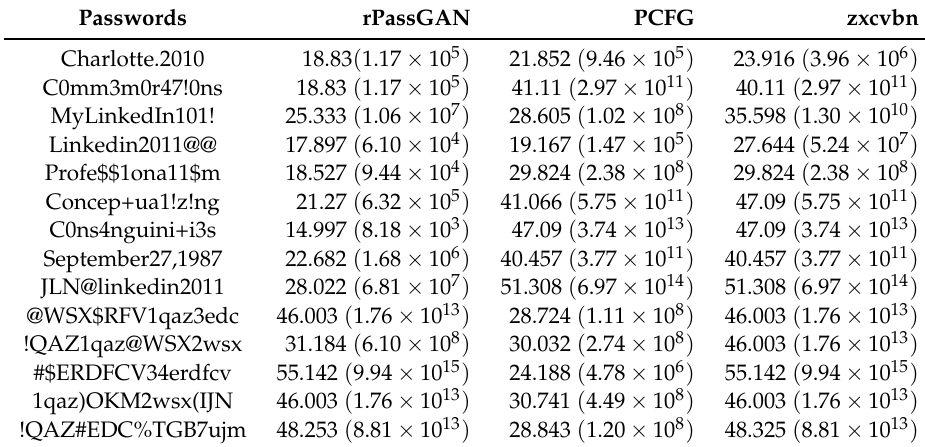
Table 6. The example results of password strength estimation, where rPassGAN showed the lowest